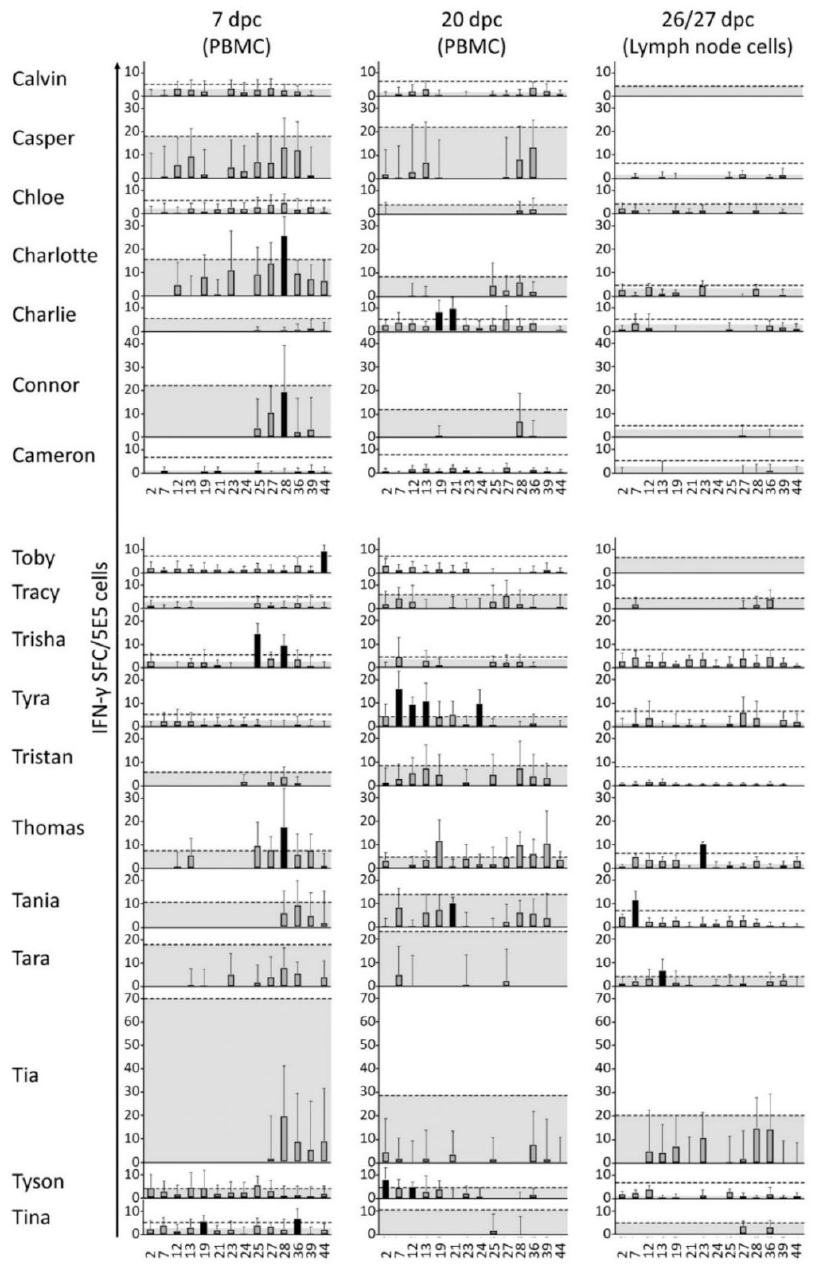
Figure 5. Overview of cell-mediated immune responses to peptides post-challenge. At dpc 7 and 20, 5 × 10 5 freshly purified peripheral blood mononuclear cells (PBMCs) were restimulated separately with 14 selected peptides and with media as a background control. At euthanasia (dpc 26/27), 3 × 10 5 cells derived from the lymph node were treated the same way and the counts were normalized to 5 × 10 5 cells/well for comparison with the PBMC counts. The response to restimulation is presented here as columns indicating the average number of IFN- γ spot forming cells (SFC) in response to restimulation with peptide (signal) minus the average number of SFC in response to restimulation with medium (background). Error bars represent the corresponding standard deviations. Upper edges of the gray area represent the subtracted average backgrounds for reference. Dashed lines indicate ratio-2 thresholds. This is defined either as 2 × background, or as 8 representing the limit of detection in cases where 2 × background is less than 8. Black columns represent positive peptide responses according to the DFR method. Peptides are indicated on the x-axis with reference to the ID column in Table